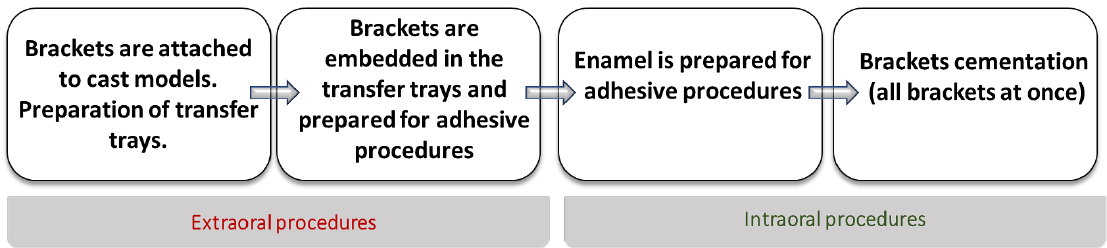
Figure 1. The stages of Silvermann’s technique.